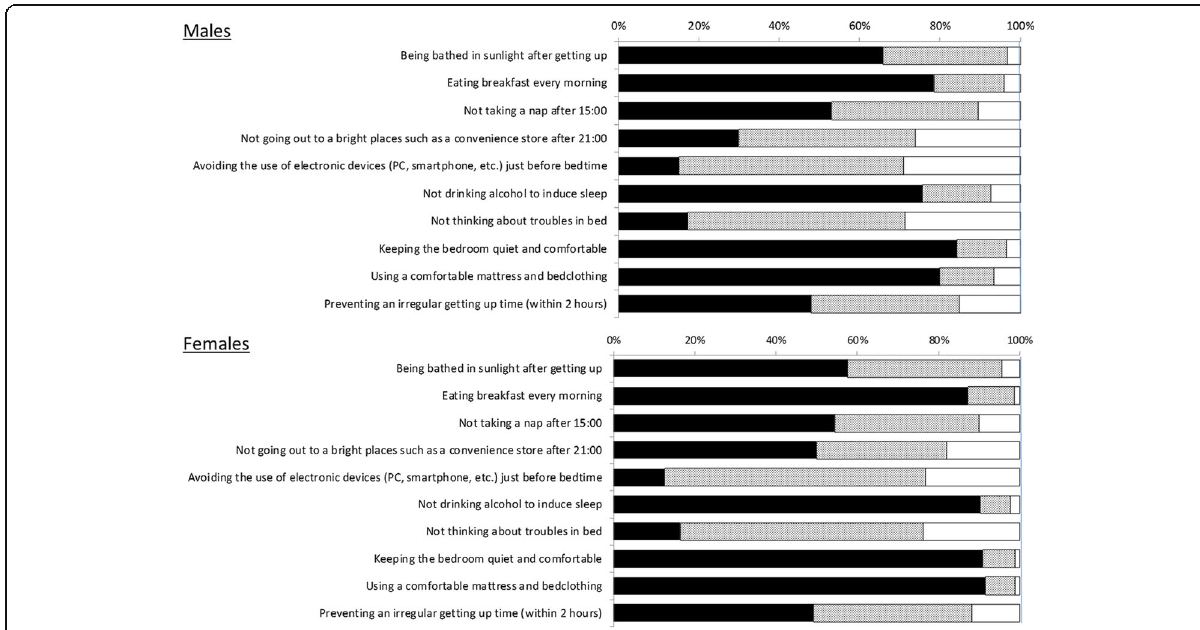
Fig. 1 The results for sleep hygiene. ■ : “ I already do so. ” , ⊡ : “ I may be able to, but do not already do so. ” , and □ : “ I think it is difficult to do so